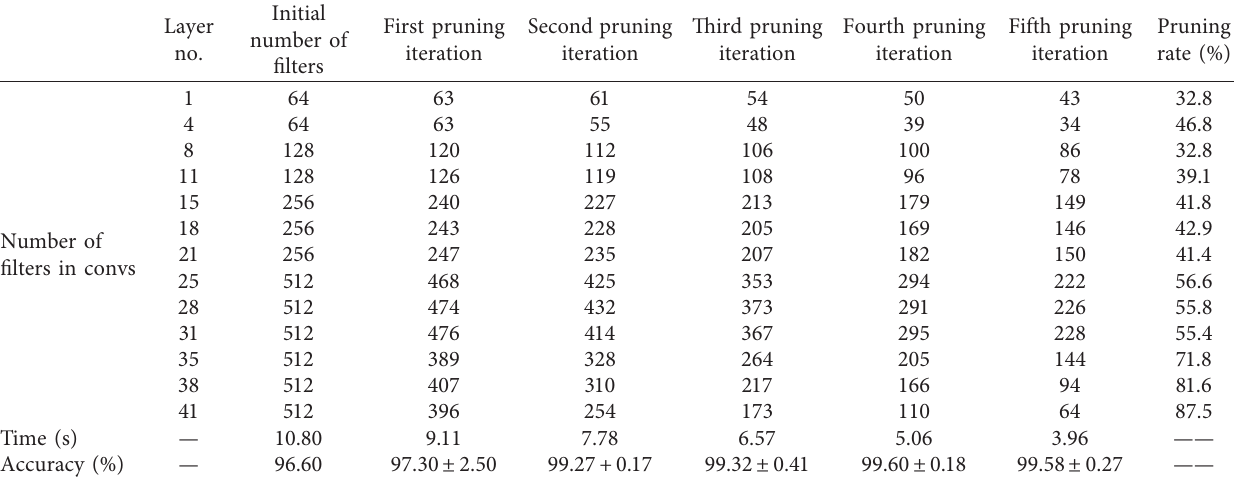
Figure 12: Comparison of training processes of three improved VGG16 architectures: (a) training accuracies, (b) training loss functions, and (c) test accuracies. Table 8: Filter pruning based on Taylor